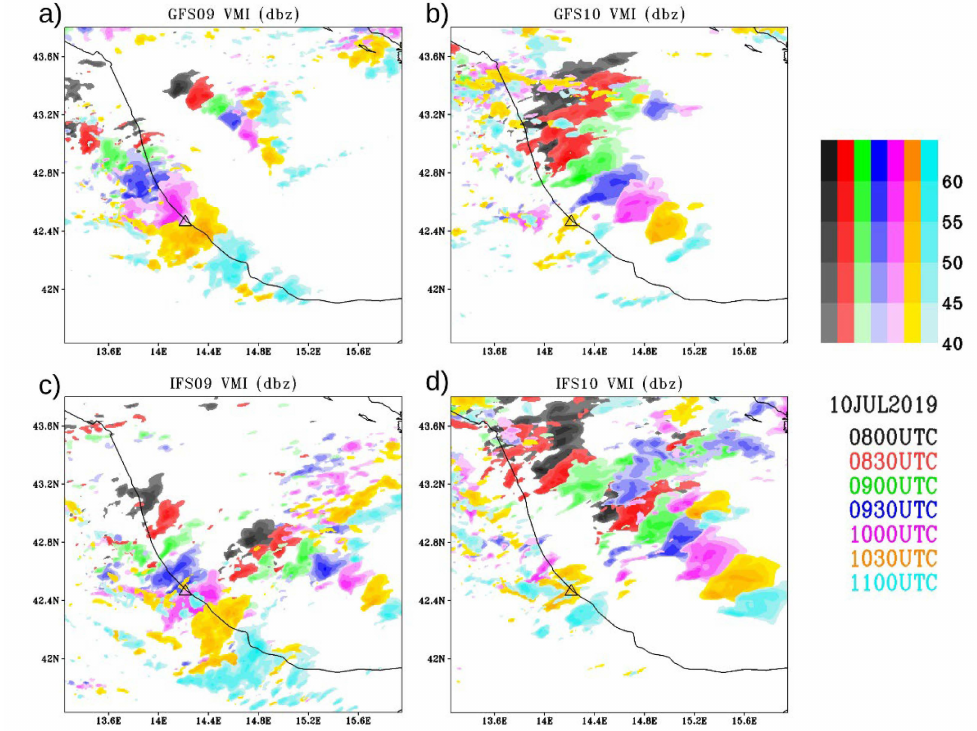
Figure 5. Simulated VMI (dBZ) at 7 instants from 08:00 until 11:00 UTC, 10 July 2019, according to: GFS09 ( a ), GFS10 ( b ), IFS09 ( c ), and IFS10 ( d ). In order to avoid superimposition between VMIs